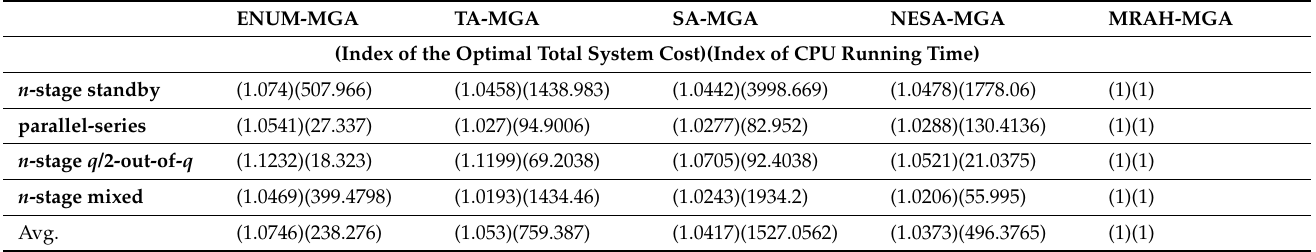
Table 47. The relative comparison indices for the optimal total system cost and CPU running